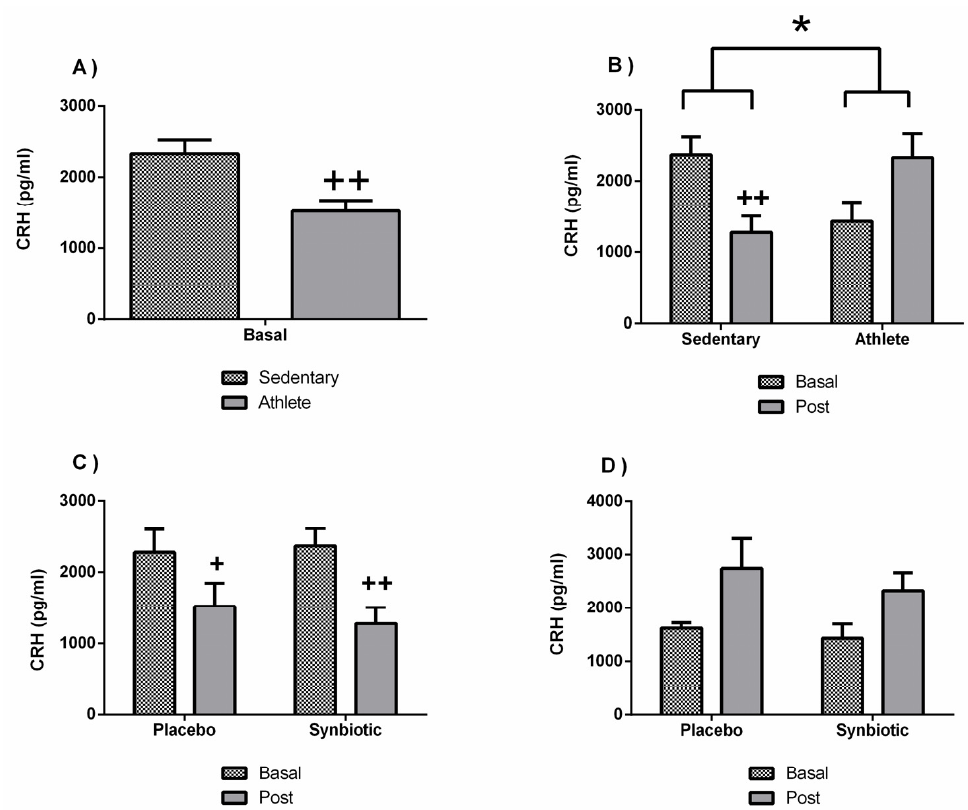
Figure 10. Effect of training and consumption of a synbiotic in this condition on corticotropin- releasing hormone (CRH) levels. ( A ) Concentrations of CRH in sedentary individuals. and athletes ( n = 13); ( B ) Influence of training on the effects of the synbiotic on the hormone CRH ( n = 7 and n = 6 in sedentary and athlete groups, respectively); ( C ) Effect of the consumption of the synbiotic on CRH in sedentary individuals with respect to placebo ( n = 7) or with synbiotic ( n = 7); ( D ) Effect of the consumption of the synbiotic on CRH in athlete individuals with placebo ( n = 6) or with synbiotic ( n = 7). The determinations are expressed by the mean ± SD of each of the samples. * p < 0.05 sedentary group versus athlete group; + p < 0.05 and ++ p < 0.01 with respect to the baseline.